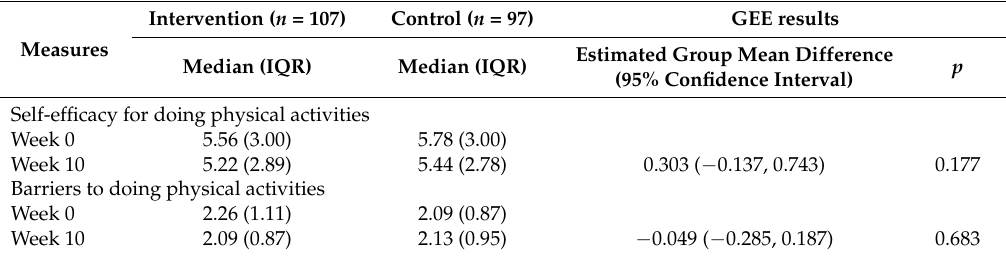
Table 4. GEE results of fitness test items between IG and